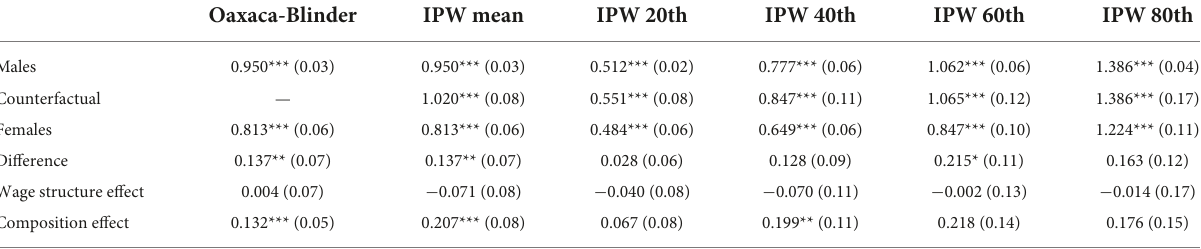
TABLE 2 Aggregate